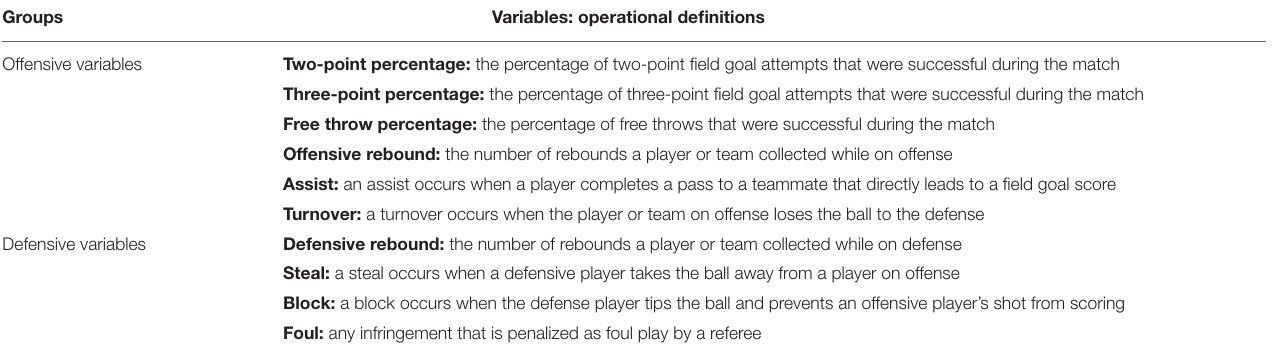
TABLE 1 | Selected technical performance-related match